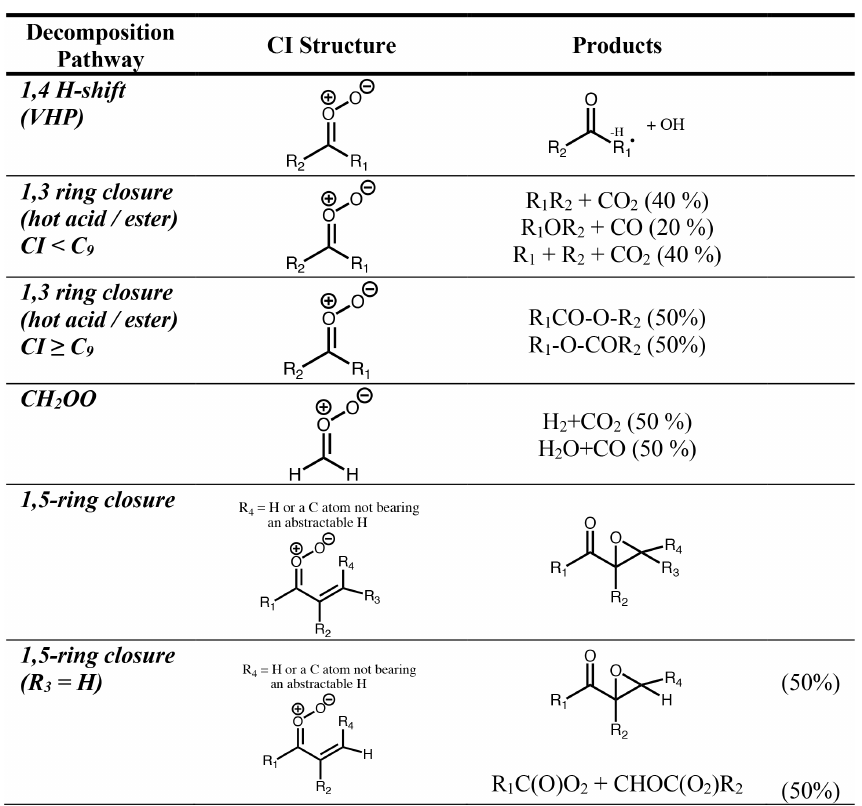
Table 2. Decomposition pathways and products for CI in the protocol.